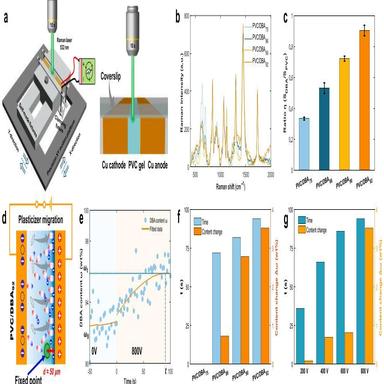
Migration of plasticizer within PVC gel during electrical stimulation. The in-situ testing platform, consisting of confocal Raman microscopy and a self-made PVC gel electrical stimulation module, was used to characterize the migration of plasticizer within PVC gel during electrical stimulation (a, d). Coverslip was employed to limit the deformation of PVC gel in the focal direction during electrical stimulation, thus avoiding the influence of focal length changes on Raman signals. The ratio η was derived fr